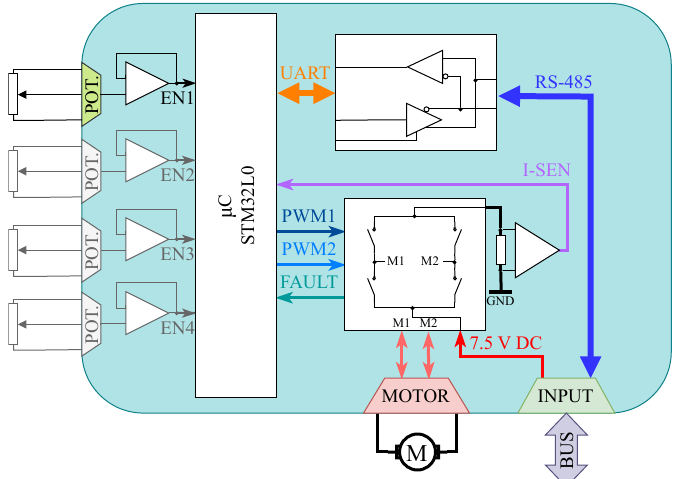
Figure 11. Diagram of DRIVER servo unit; two configurations, with one or four resistive position sensors, are used in the